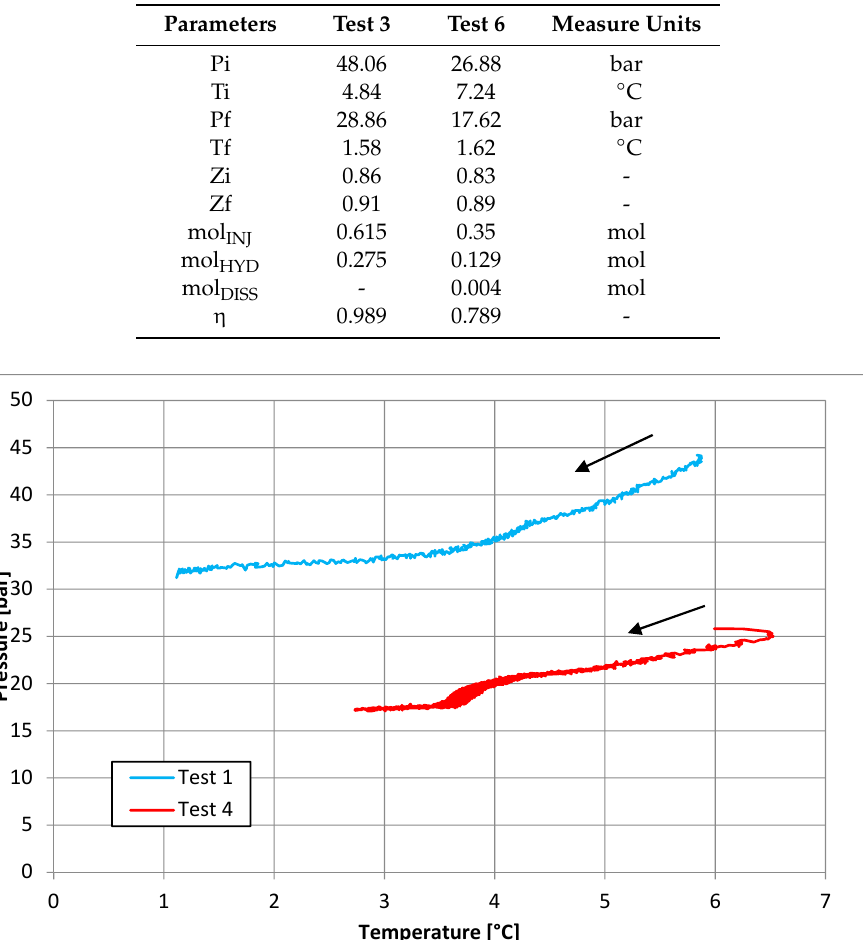
Figure 4. Comparison between Test 1, carried out using CH 4 , and Test 4, performed with CO 2 . Processes 2020 , 8 , x FOR PEER REVIEW